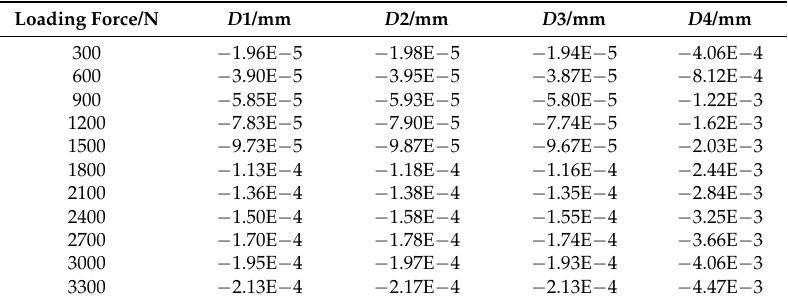
Table 8. Axial deformations of the four branches.